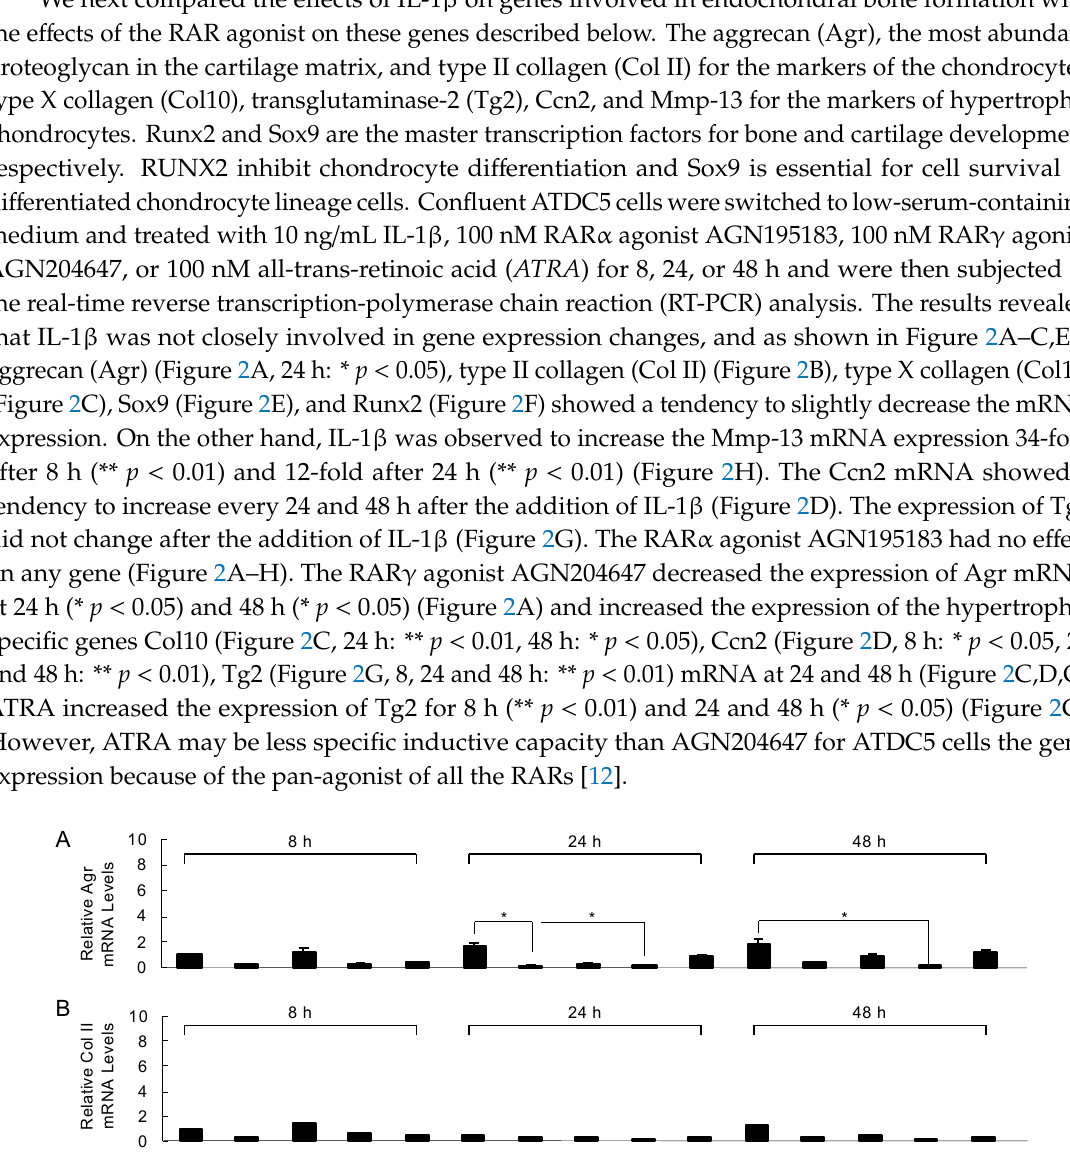
Figure 2. Modulation of the expression of chondrocyte-specific genes’ mRNA by IL-1β, retinoid receptor (RAR)-α agonist (AGN195183), RAR-γ agonist (AGN204647), or RAR inverse agonist (AGN194310) in 10-day cultures of ATDC5 cells. ATDC5 cells were exposed to 10 ng/mL IL-1β, 100 nM AGN195183, 100 nM AGN204647, or 100 nM all-trans-retinoic acid (ATRA) for 8, 24, or 48 h. Total RNA from these cells was used in a real-time RT-PCR for the analysis of the mRNA expressions of aggrecan (Agr) ( A ), type II collagen (Col II) ( B ), type X collagen (Col10) ( C ), Ccn2 ( D ), Sox9 ( E ), Runx2 ( F ), transglutaminase-2 (Tg2) ( G ), and matrix metalloproteinase-13 (Mmp13) ( H ). The values in the graph indicate the relative mRNA level of the fold changes. Columns, mean of triplicate